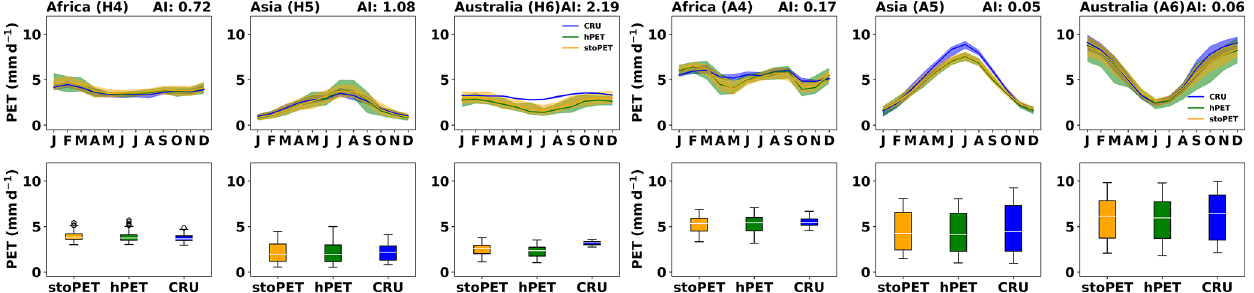
Figure 9. The seasonal PET and box plots for three datasets over Africa, Asia, and Australia (including the Oceania region) for (a) humid and (b) arid locations, as shown in Fig. 7. The box plots show the distribution of each dataset over the 20-year period. The box indicates the IQR (25th–75th), while the upper whiskers are set to (75th + 1 . 5 × IQR), and the lower whiskers are set to (25th − 1 . 5 ×